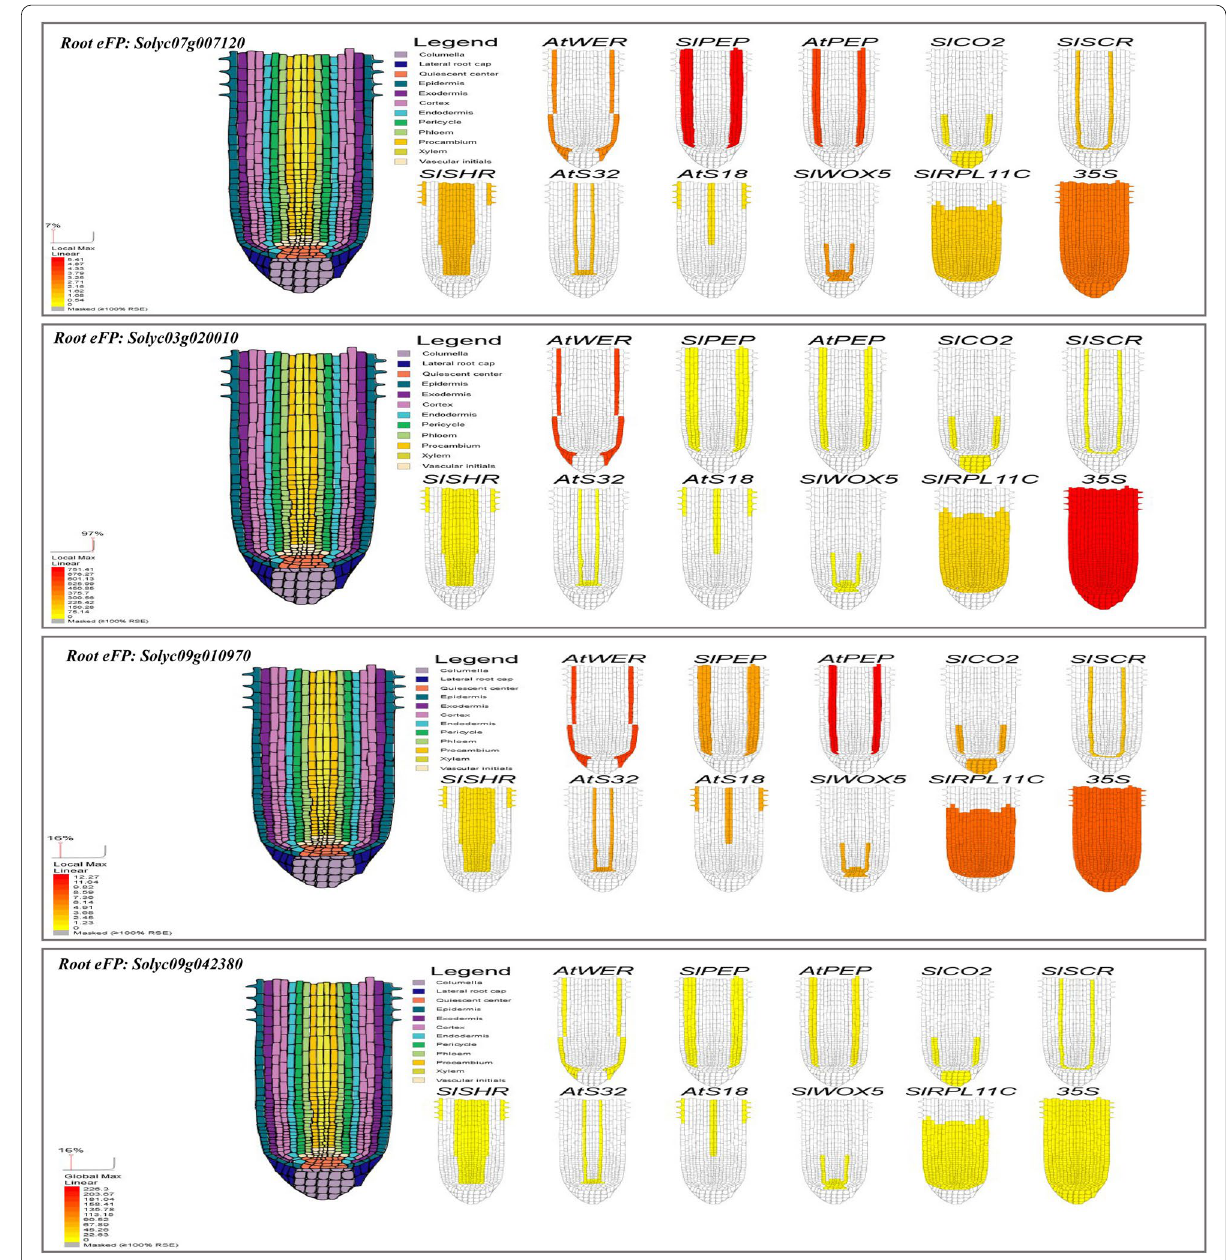
Fig. 7 Visualization of the putative a “root electronic fluorescent pictograph” browsers for exploring the putative expression of Solyc07g007120, Solyc03g020010, Solyc09g010970 , and Solyc09g042380 genes at different root cell types- and tissues-specific under various promoter toolboxes, such as AtWER, SIPEP, AtPEP, SICO2, SISCR , SISHR , AtS32 , AtS18 , SIWOX5 , SIRPL11C , and 35S promoters. The bar represents the expression scale (the more intense the red color, the more gene expression) http:// bar. utoro nto. ca/ eplant_